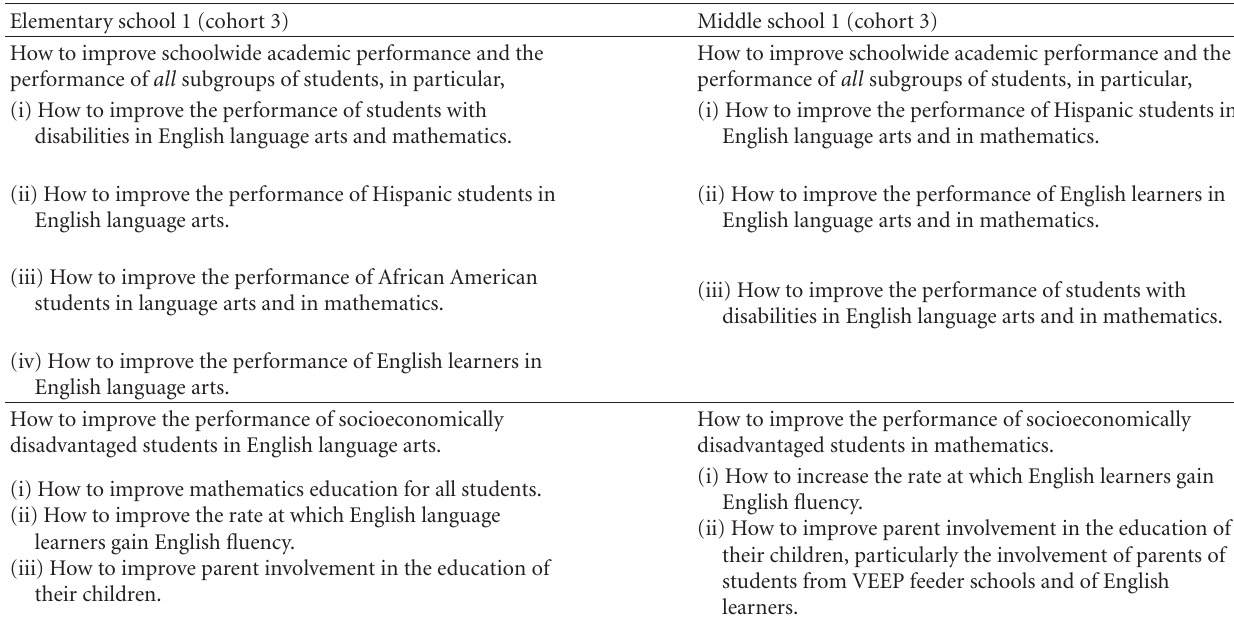
Table 1: Listing of primary challenges in two schools’ restructuring